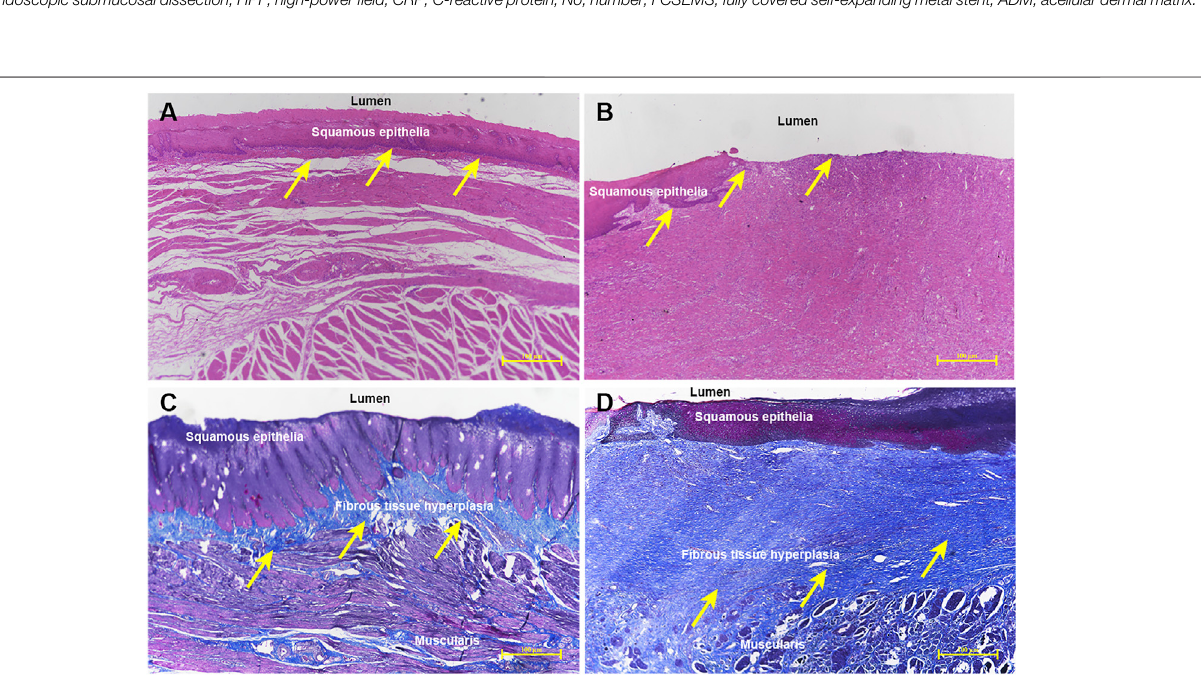
Frontiers in Bioengineering and Biotechnology |